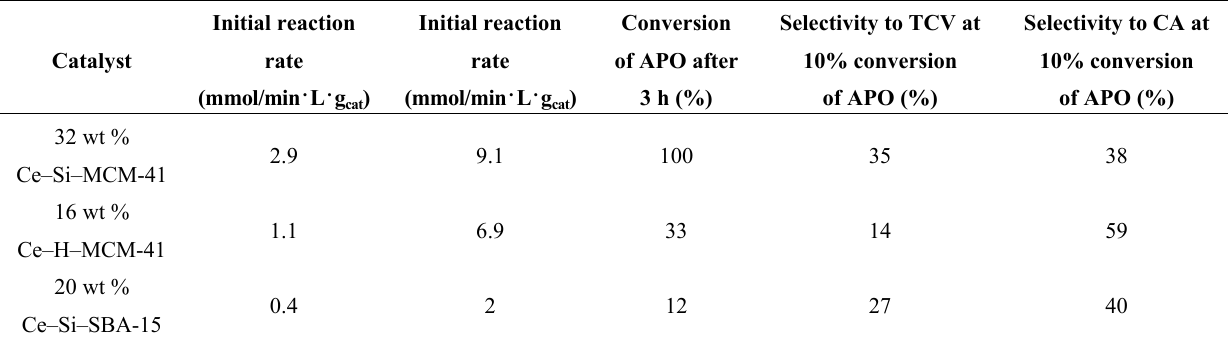
Table 2. Initial reaction rate within the 10 min from the beginning of isomerization reaction, conversion of α -pinene oxide and selectivities to the desired trans -carveol and to the by-product campholenic aldehyde at 10% conversion of α -pinene